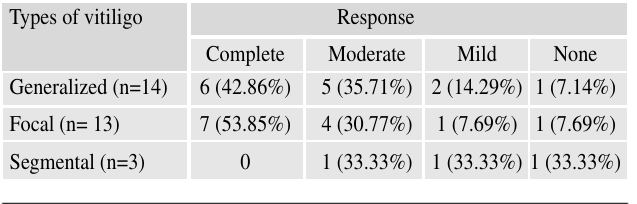
Table II: Response after 12 weeks in different types of vitiligo(cid:13)